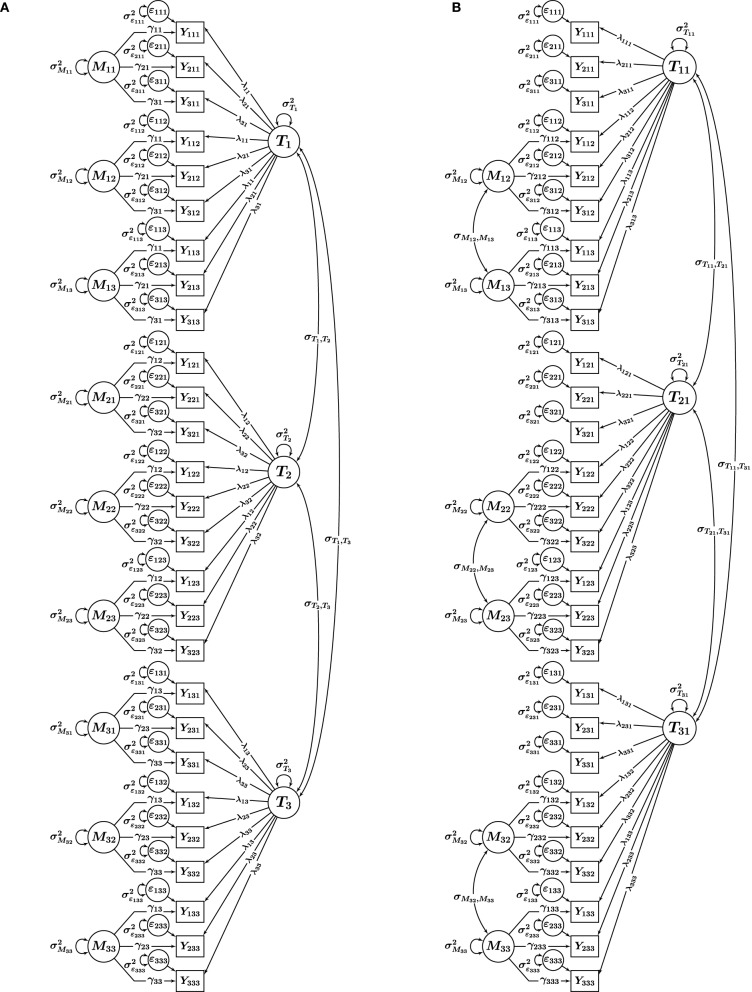
CFA-MTMM models for a design with i = 1, 2, 3 indicators, t = 1, 2, 3 traits, and m = 1, 2, 3 methods. (A) CT-UMconstrained, (B) CT-C (M−1). Yitm, observed variables; Tt, Ttm, trait factors; Mtm, trait-specific method factors; ϵitm, measurement error variables; λit, λitm, trait factor loadings; γit, γitm, method factor loadings.